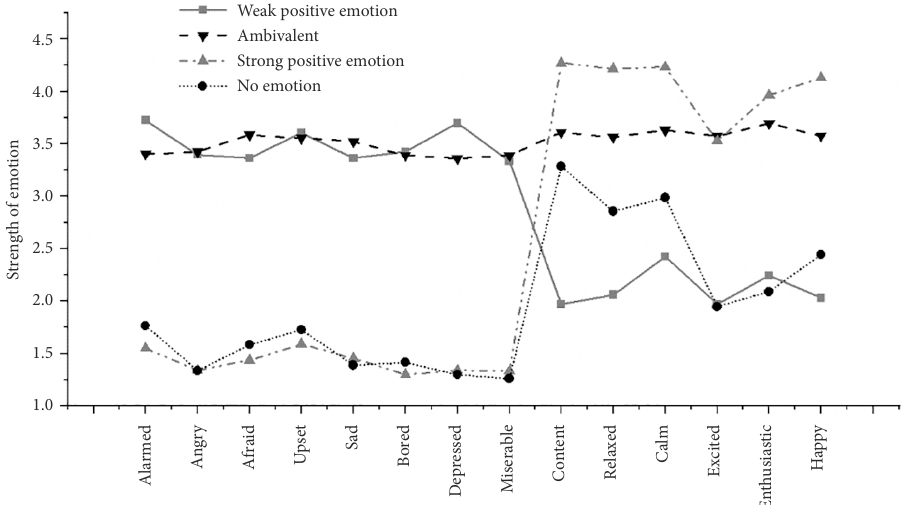
Figure 2. The intensity of emotions to recycled water for each profile: Weak Positive Emotion, Ambivalent, Strong Positive Emotion, and No Emotion